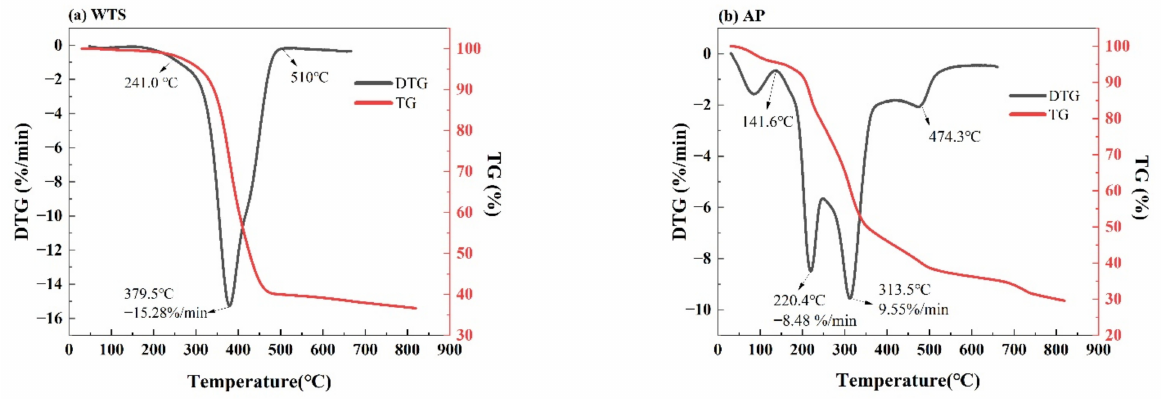
Figure 3. TG and DTG curves of ( a ) WTS and ( b ) AP at 25 ◦